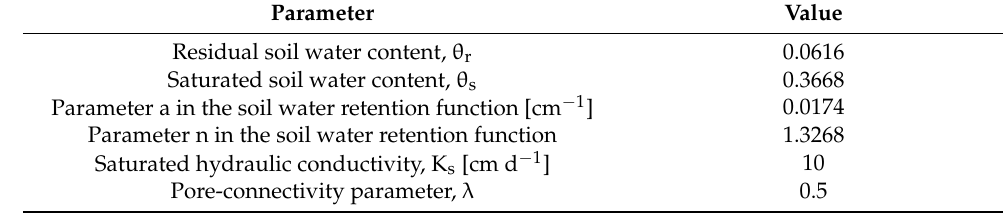
Table 4. Soil hydraulic parameters (van Genuchten parameters and saturated hydraulic conductiv- ity).